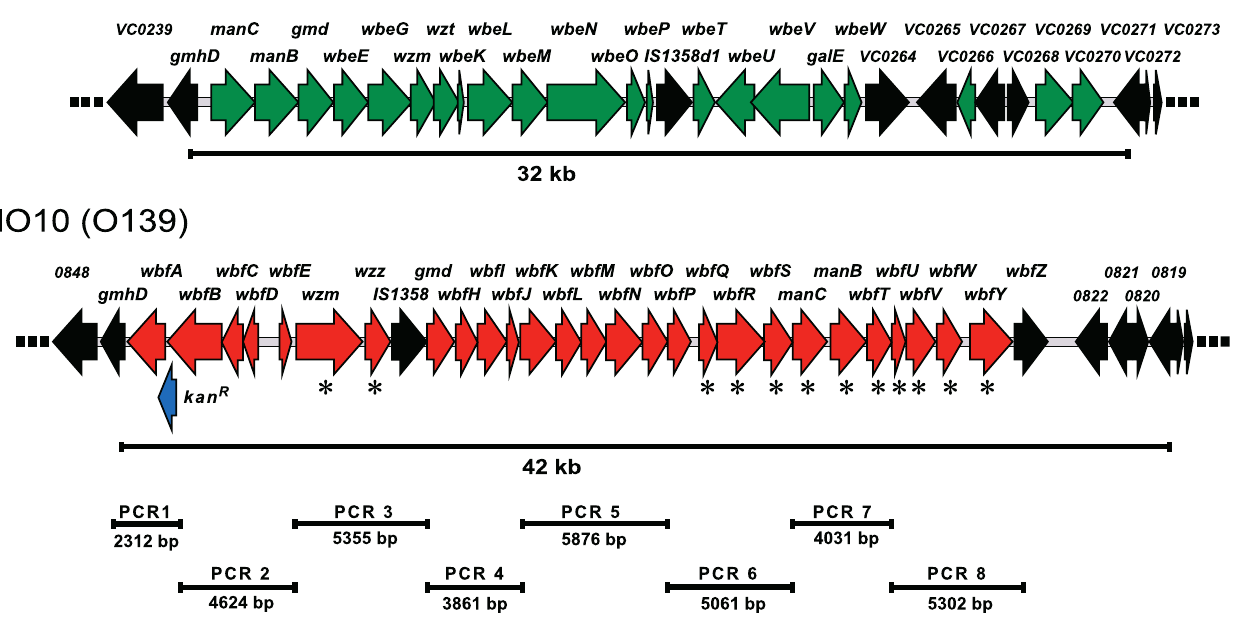
Figure 1. Comparison of the O-Antigen–Encoding DNA Region ( wb *) of Strain A1552 (O1) and MO10 (O139) The genetic organization of the O1-specific and O139-specific DNA clusters on chromosome I of V. cholerae are shown (adapted from Heidelberg et al. [31], Stoeher et al. [28], Yamasaki et al. [33], Chatterjee and Chaudhuri [30], and the whole genome shotgun sequence of V. cholerae MO10). Genes and their orientation are denoted by arrows. Gene color code: green, O1-specific; red, O139-specific; black, homologous genes. The blue arrow depicts the Kan R cassette ( aph gene) integrated between wbfA and wbfB in strain VCO139-Kan. The bars below show the minimum size of the exchanged DNA fragments. The asterisks mark the 12 O139-specific genes present on the microarrays. PCR primers for the O139 region were designed to obtain the indicated O139-specific PCR fragments 1 through 8 shown at the bottom. ORFs: 0848 ¼ VchoM_01000848 (homolog to VC0239), 0822 ¼ VchoM_01000822 (homolog to VC0265), 0821 ¼ VchoM_01000821 (homolog to VC0267), 0820 ¼ VchoM_01000820 (homolog to VC0268), 0819 ¼ VchoM_01000819 (homolog to VC0271).